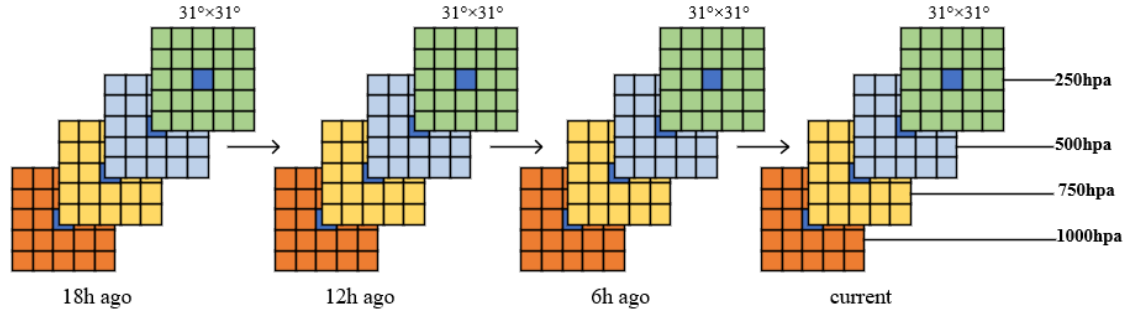
Figure 3. The 3D time series structure of a tropical cyclone, reprinted with permission from Ref. [19]. 2022, Springer Nature.